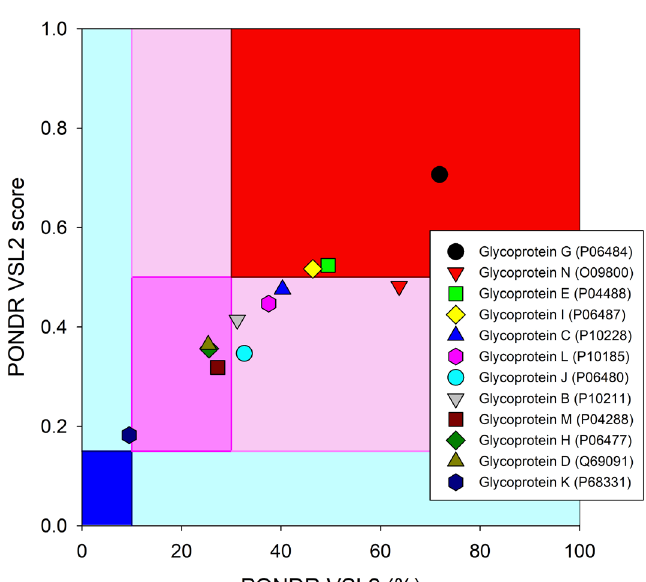
Figure 3. Intrinsic disorder status of 12 surface glycoproteins from HSV-1. The disorder predisposition of 12 glycoproteins from human HSV-1 (strain 17) based on disorder score and percent of disordered residues. Larger values of each parameter indicate increasing disorder. Color blocks show regions in which one can find mostly ordered (blue and light blue), moderately disordered (pink and light pink), or mostly disordered (red) proteins. If the two parameters agree, the corresponding part of the background is dark (blue or pink), whereas light blue and light pink reflect areas in which only one of these criteria